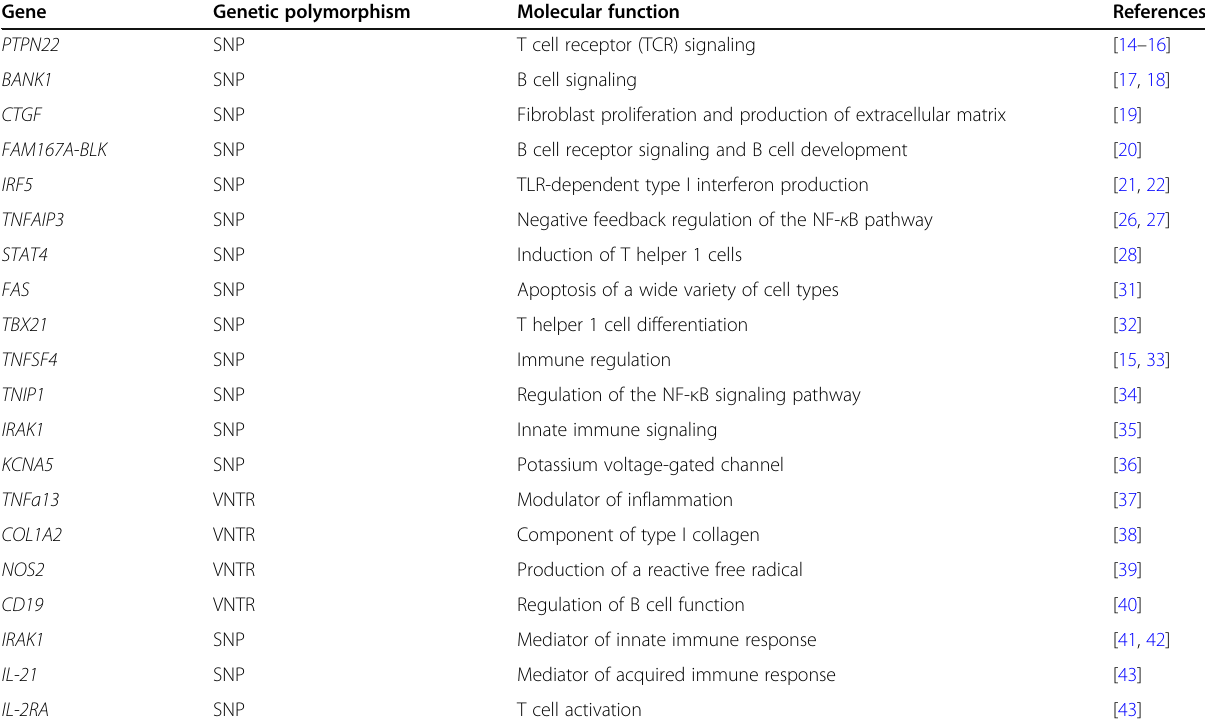
Table 1 SSc susceptibility genes identified by the CGA Gene Genetic polymorphism Molecular